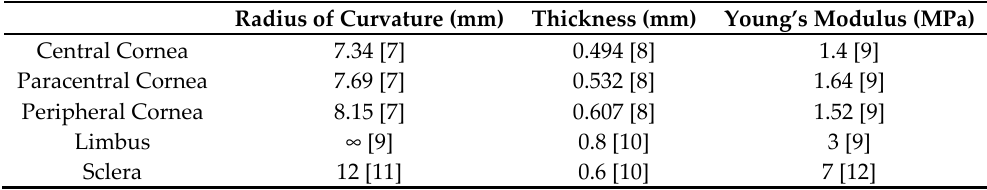
Table 1. Mean values of the fibrous layer parameters.